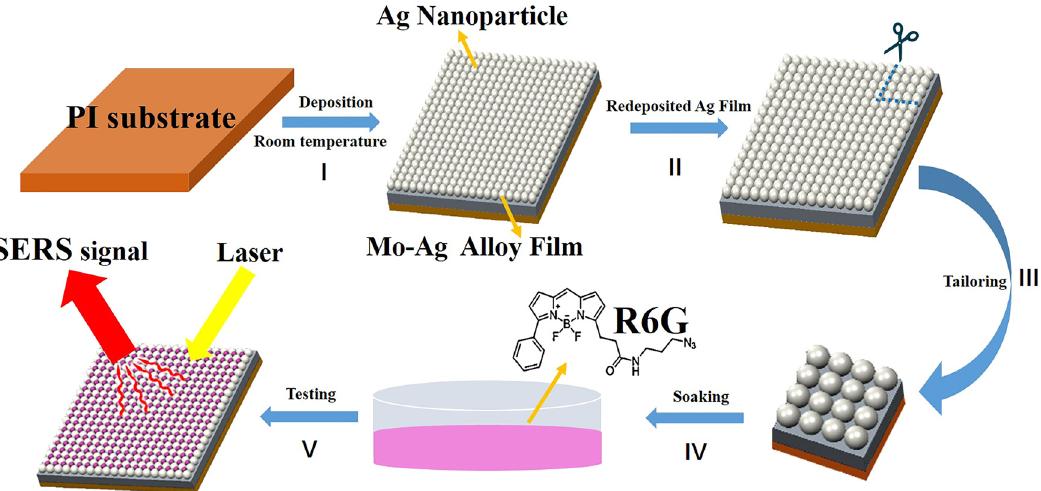
Figure 1: Schematic diagram of the Ag fi lm/Ag nanoparticles/Mo – Ag alloy fi lm formation and detection process of SERS performance: ( I ) the Mo – Ag alloy fi lms were deposited on the fl exible PI substrate at room temperature. ( II ) A layer of Ag fi lm was further sputtered on the surface of the Ag nanoparticles/Mo – Ag alloy fi lms. ( III ) The Ag fi lm/Ag nanoparticles/Mo – Ag alloy fi lm was tailored into 5 × 5 mm pieces. ( IV ) The Ag fi lm/Ag nanoparticles/Mo – Ag alloy fi lms were soaked in R6G solutions. ( V ) Using Raman spectrometer to test the